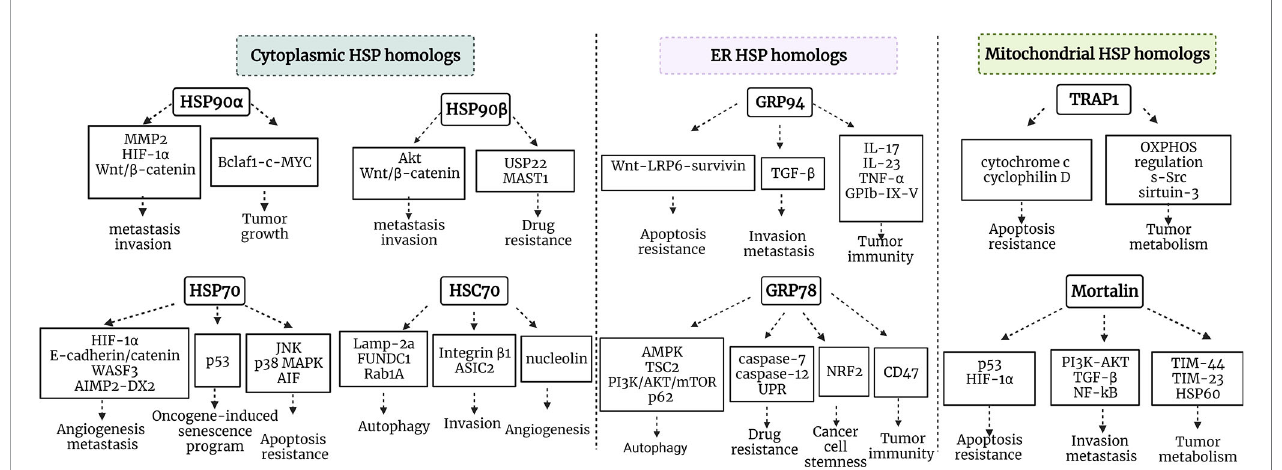
FIGURE 2 | Schematic representation of HSP90/HSP70 signaling pathways in cancer. HSP90 a and HSP90 b are cytosolic stress-inducible and constitutive members of HSP90 family, respectively, which support tumor development via multiple signaling pathways. HSP70 and HSC70 are two main cytosolic stress- inducible and constitutive members of HSP70 family, respectively, which play critical roles in the regulation of apoptosis, autophagy, oncogene-induced senescence program, angiogenesis, invasion and metastasis. GRP94 and GRP78 are ER HSP90 and HSP70 members, which play an important role in the regulation of apoptosis, invasion, metastasis, autophagy, drug resistance, cancer cell stemness and tumor immunity. TRAP1 is a mitochondrial HSP90, which plays critical role in tumor metabolism and cytoprotection of cancer cells. Mortalin is a mitochondrial HSP70 family member playing an important role in tumor metabolism, regulation of apoptosis, invasion and metastasis. MMP9, matrix metalloproteinase 9; OXPHOS, oxidative phosphorylation; Bclaf1, B-cell lymphoma 2 -associated transcription factor 1; HIF-1, hypoxia-inducible factor 1; MAST1, microtubule-associated serine/threonine kinase 1; TGF- b , transforming growth factor b ; PI3K, phosphatidylinositol 3-kinase; WASF3, Wiskott-Aldridge syndrome family member 3; TIM-44, translocase of inner membrane-44; NRF2, nuclear factor-erythroid 2-related factor; AIMP- DX2, aminoacyl-transfer RNA synthetase-interacting multifunctional protein 2 (AIMP2) lacking exon 2; MAPK, mitogen-activated protein kinase; TSC2, tuberous sclerosis 2; mTOR, mechanistic target of